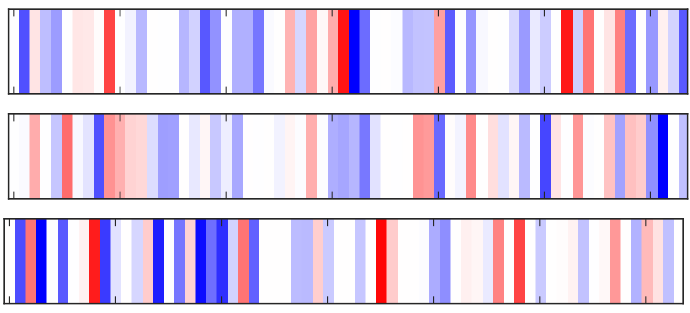
Figure 6 . Averaged signal minus background for our default network and full pre-processing. The rows show the three dense DNN layers. Red areas indicate signal-like regions, blue areas indicate background-like